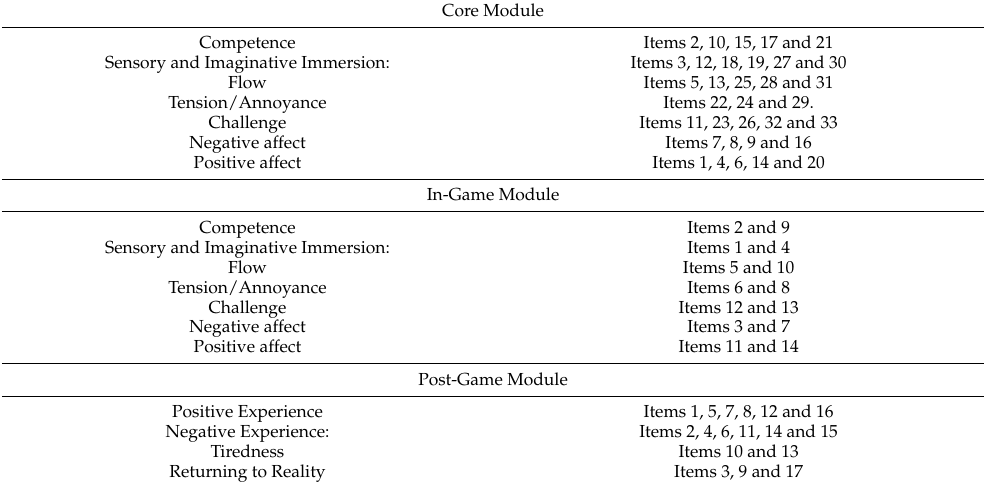
Table A3. GEQ scoring